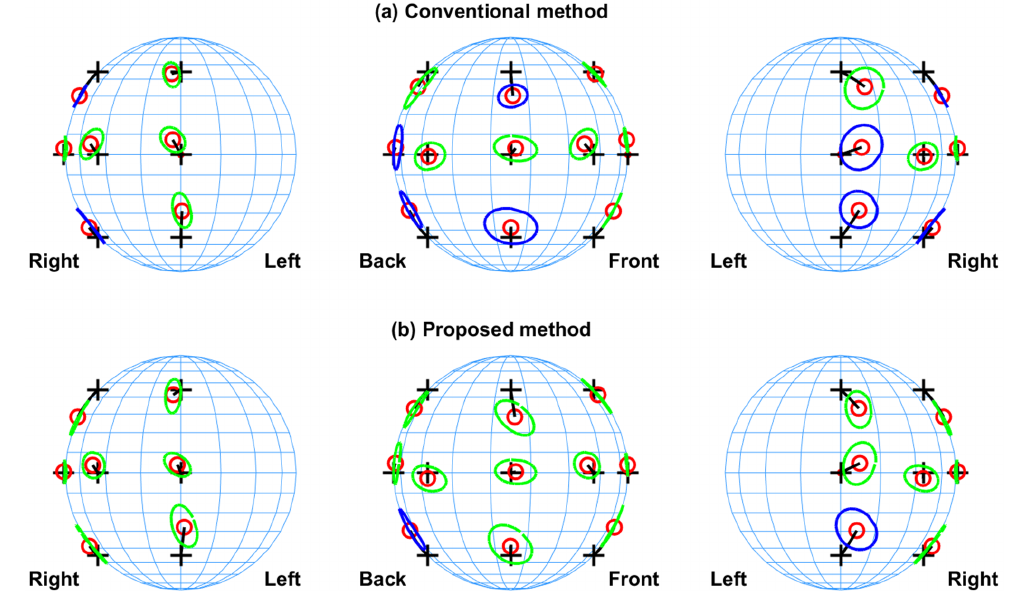
Figure 3. The statistical graph for spherical data of conventional and proposed